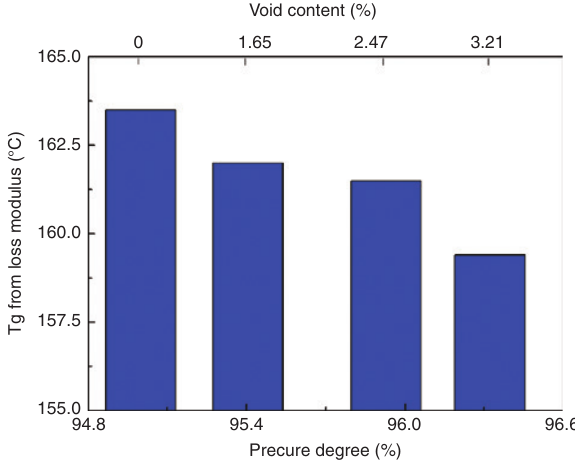
of the carbon/benzoxazine laminate vs. precure degree Figure 6: T g (or void content) of the prepregs.